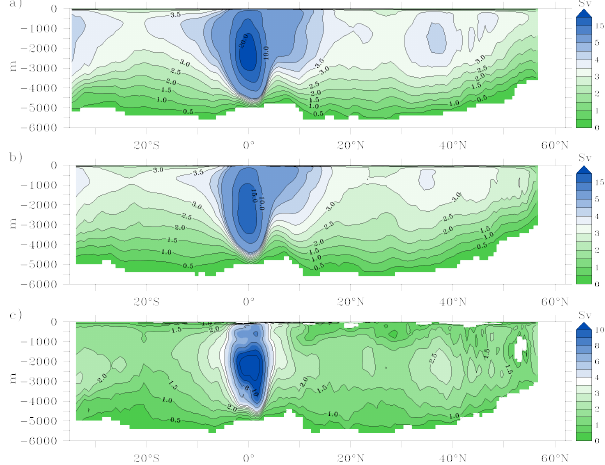
Figure 19: Standard deviations of the Atlantic MOC in the 1 / 4 ◦ (top) and 1 ◦ versions of the model. The standard deviation of the additional variability occurring in the 1 / 4 ◦ model is shown in the bottom panel. √ It is calculated according to variance B 025 − variance B 100 .